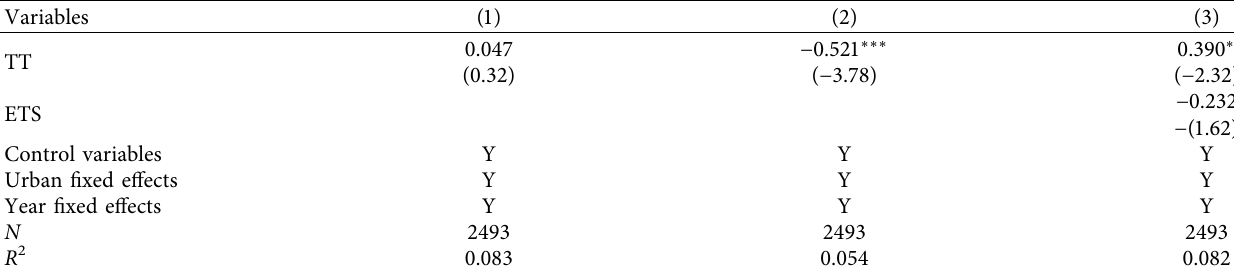
Table 6: Robustness tests results.